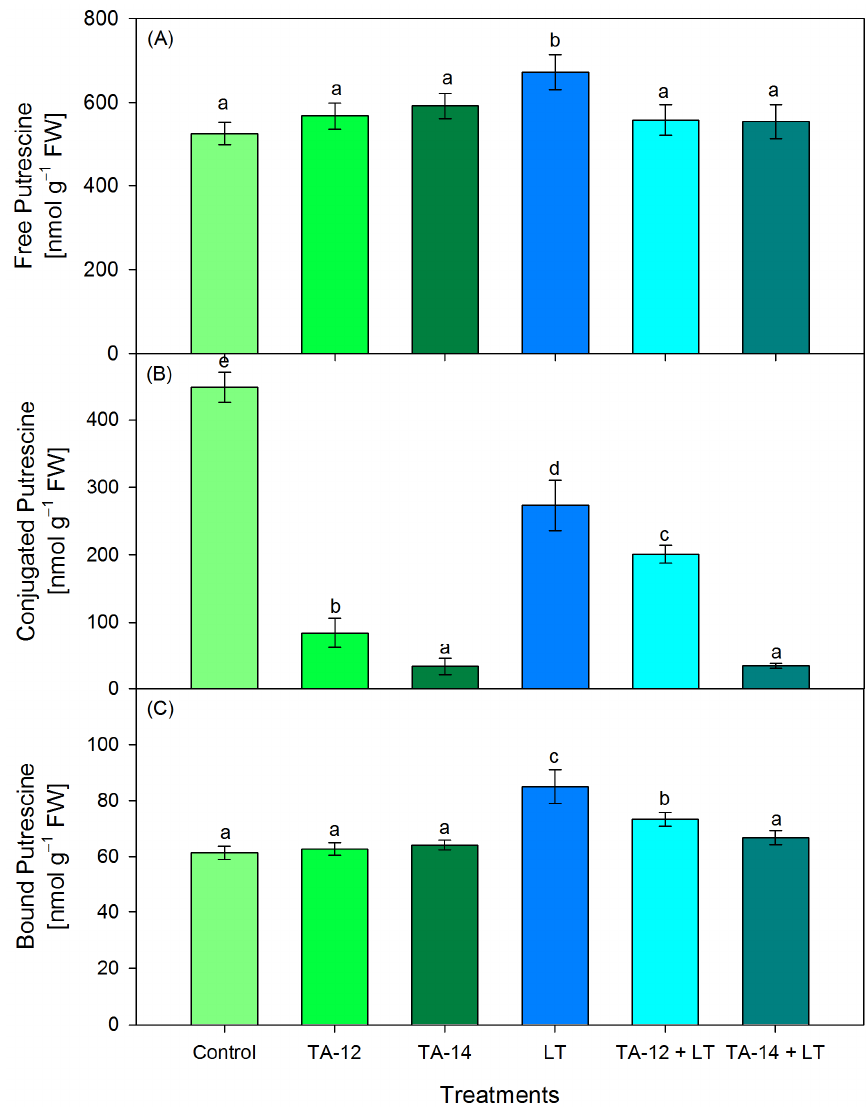
Figure 3. Content of free ( A ), conjugated ( B ) and bound ( C ) putrescine (Put) in pea sprayed with TA-12 or TA-14 and subjected to low temperature (−1 °C, LT) for 24 h. Data are mean values ± SE. Different letters designate statistically significant difference at p < 0.05.